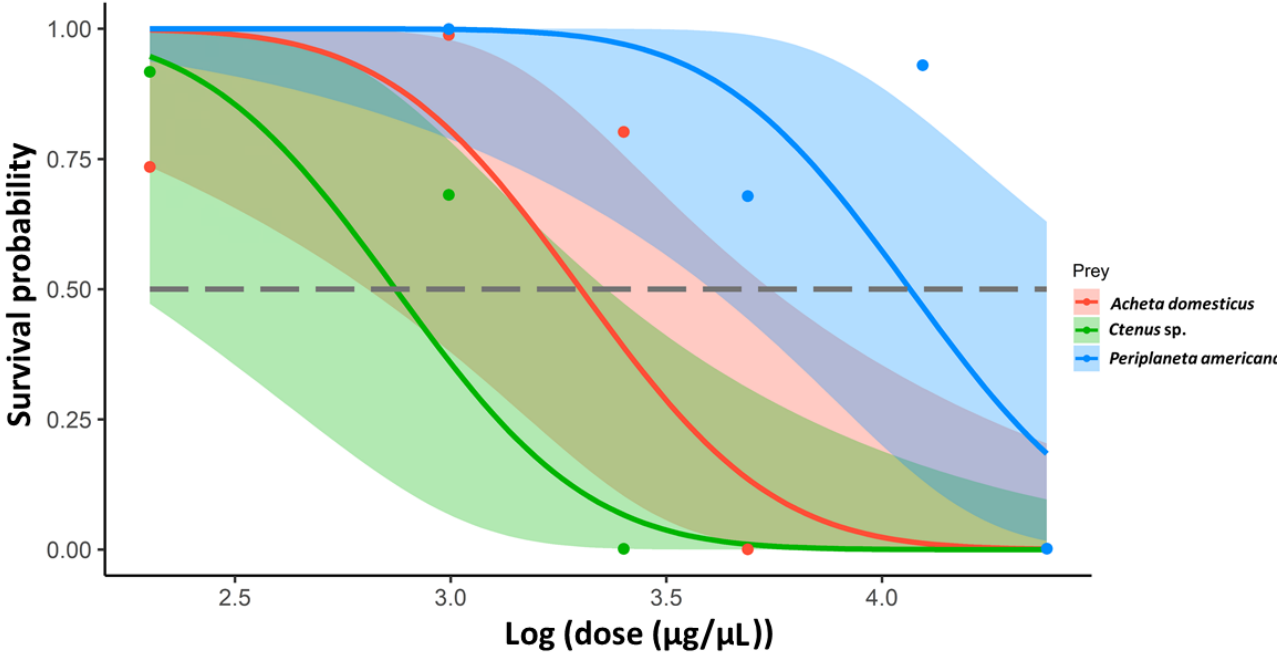
Figure 4. The survival curves as a function of log(dose). Median lethal dose expressed as mg of venom per kg of prey are expressed in Table 3. Shaded bands represent confidence intervals. All parameters were estimated using a binomial generalized linear